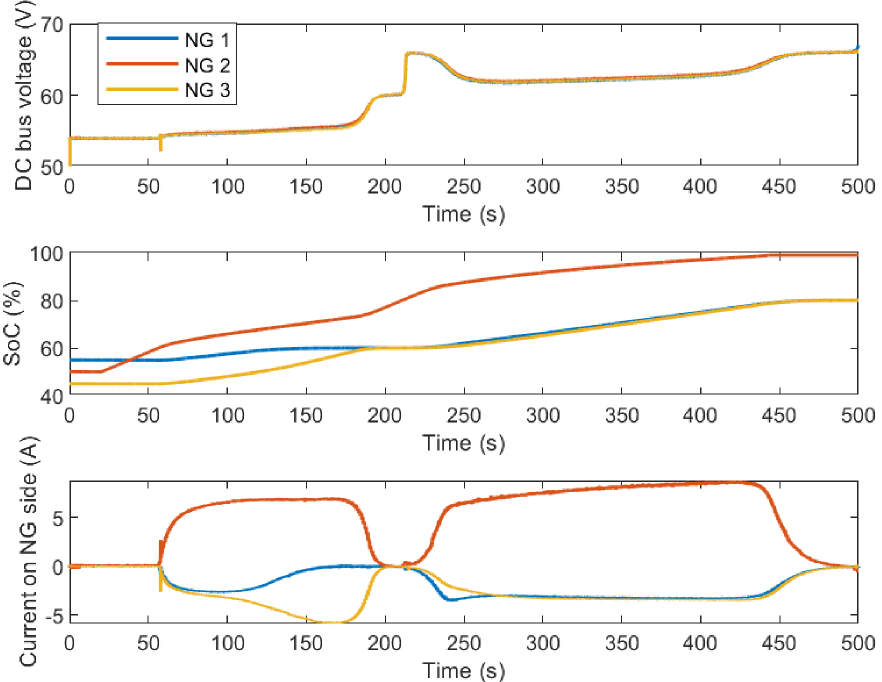
Figure 23. Evolution of the DC bus voltage, the SoCs and the currents exchanged between the converters at different operating